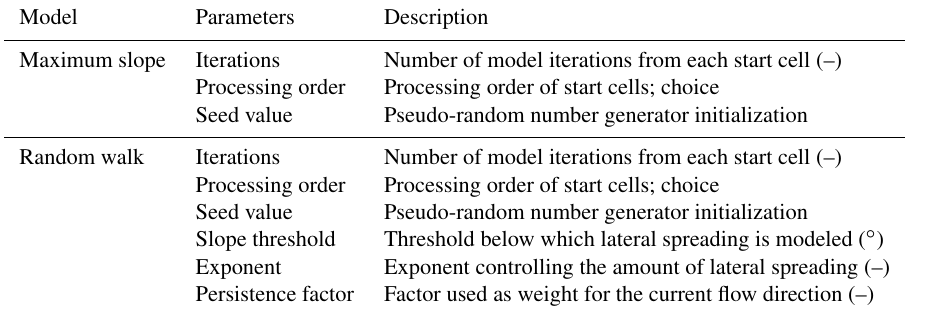
Table A1. The process path parameters of the GPP model.